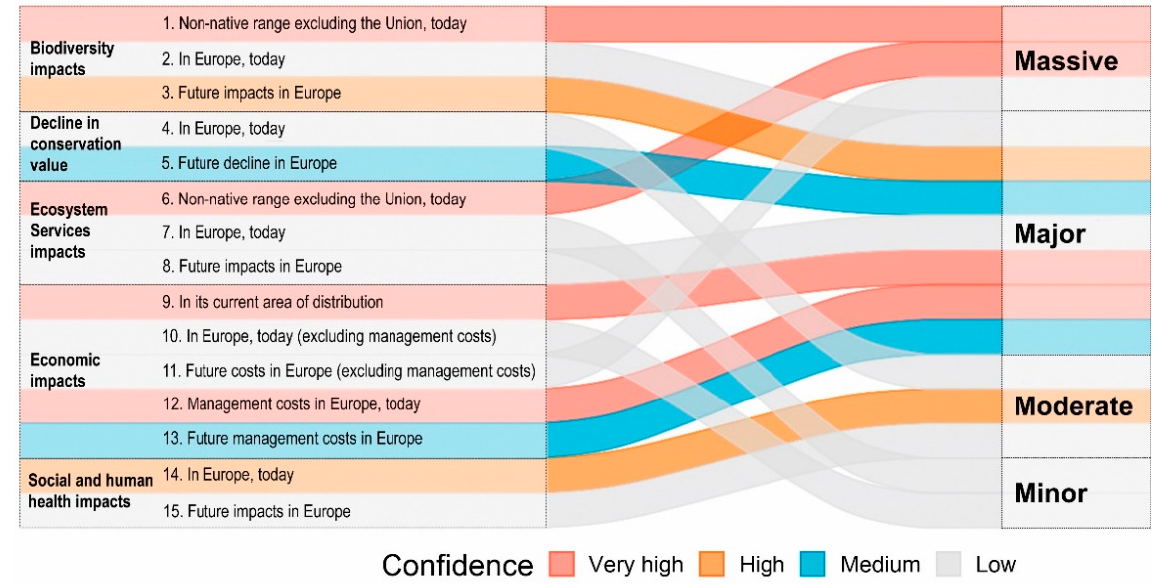
Figure 4. Assessment of lionfish current and future impacts on (i) biodiversity (at all levels of organization, e.g., decline in native species, changes in native species communities, hybridization), (ii) conservation value with regard to European and national nature conservation legislation, (iii) economy, (iv) ecosystem services (provisioning, regulating, and cultural services), and (v) society and human health, using the evaluation scheme shown in Supplementary Material 1.